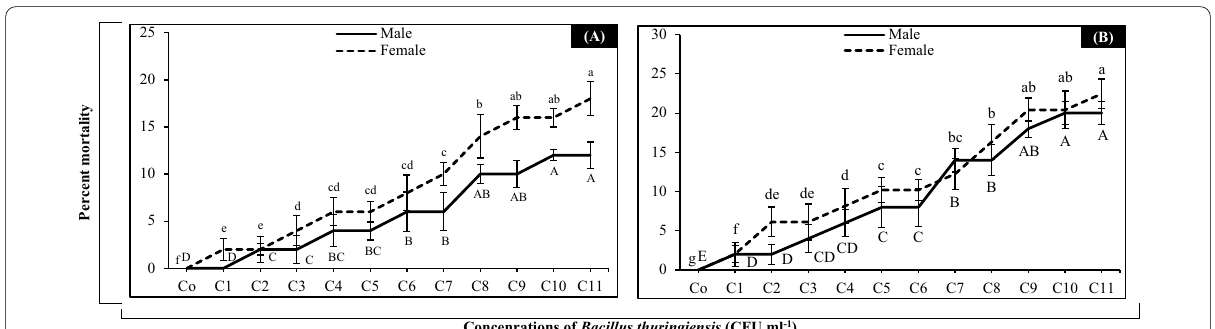
Fig. 4 Percent mortality of both sexes of Bactrocera zonata for different concentrations of Bacillus thuringiensis (solid and square-dotted lines represent mortality of male and female Bactrocera zonata , respectively; Capital and small letters represent mortality of male and female Bactrocera zonata , respectively) at 5 days post-exposure intervals (a) and 7 days post-exposure intervals (b) . Concentrations on x-axis represents C0 C1 1 10 3 CFU ml − 1 , C2 = ×